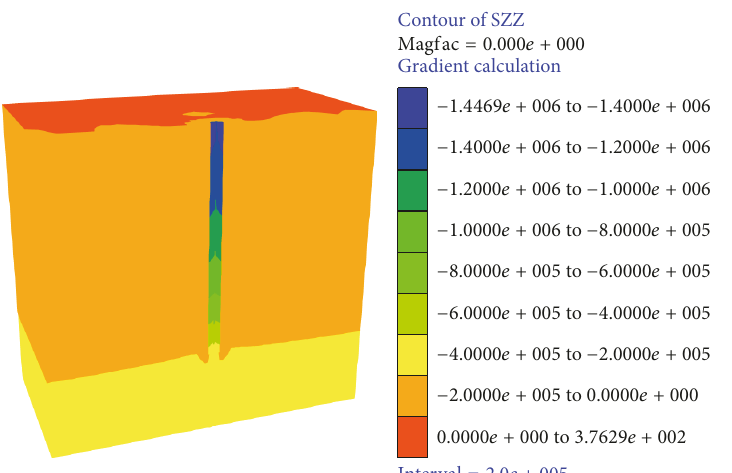
Figure 2: Typical contour of lateral stress under a load of 385 kN.